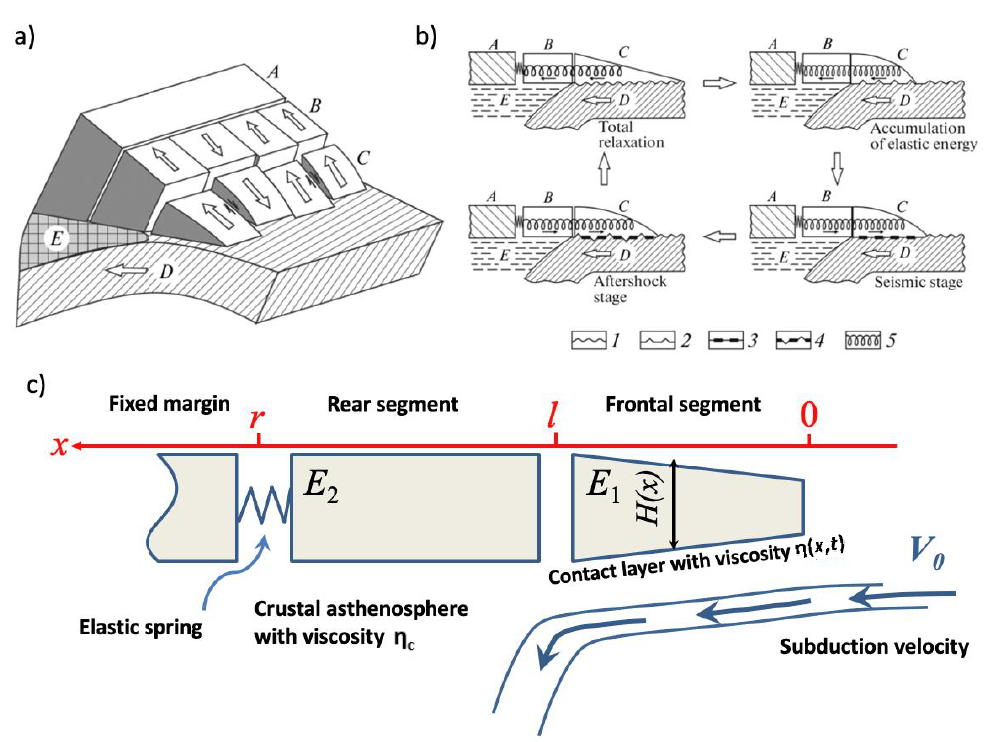
Figure 8. ( a ) Three-dimensional geometry of the two-segment keyboard-block model, ( b ) seismic deformation cycle phases, and ( c ) vertical plane section for the particular block along x -direction. A is the fixed undeformable continental margin; B is the rear-segment block; C is the frontal-segment block; D is the subducting plate; E is the crustal asthenosphere. (1) Two-dimensional geometry for the no deformation state; (2) stress accumulation (preseismic) phase; (3) coseismic phase (destruction of the crust); (4) postseismic (aftershock) phase with continued oceanward motion of the